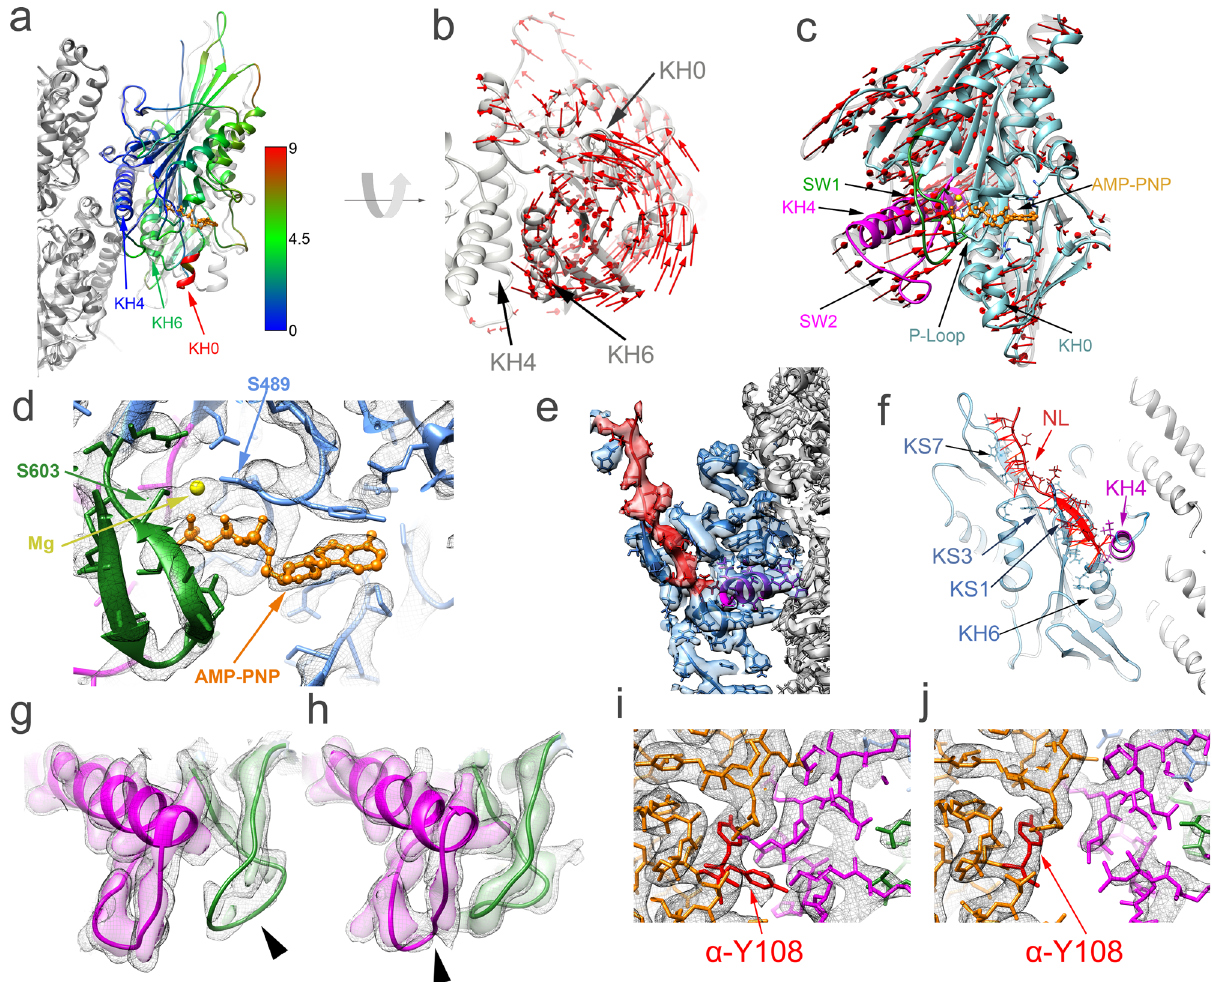
Fig. 4 Closed nucleotide-binding pocket conformation. a Superimposed MT-K748-ANP (colored) and MT-K748-ADP (semi-transparent gray) structures aligned to their corresponding tubulin β -chains. The KIF14 motor domain of the MT-K748-ANP structure is colored by the distance to equivalent C α atoms in the MT-748-ADP structure according to the inset scale (in Å). b Displacement vectors (red arrows) between equivalent KIF14 motor domain C α atoms in the MT-K748-ANP (light gray) and MT-K748-ADP structures after alignment as in ( a ). c Nucleotide-binding pocket comparison with displacement vectors (red) between MT-K748-ADP (semitransparent gray) and MT-K748-ANP (colored) structures after aligning their P-loops. d Detail of the nucleotide-binding pocket with corresponding densities (gray mesh) in the MT-K748-ANP structure. e Detail of the neck-linker domain with corresponding densities (semitransparent colored surface) in the MT-K748-ANP structure. f Neck-linker area in the MT-K748-ANP structure showing interacting residues with other areas of the motor domain. Pseudo-bonds between interacting atoms are represented as red lines (determined and displayed using the fi nd clashes and contacts routine in UCSF-Chimera, see “ Methods ” ). g , h Switch loop regions in the MT-K748-ADP ( g ) and MT-K748-ANP ( h ) structures. Corresponding densities are shown at two iso-density contour levels, higher (colored semitransparent surface) and lower (gray mesh). Densities that disappear at the higher contour level (presumably more disordered) are pointed with the black arrowheads. i , j Detail of the microtubule-KIF14 interface of the MT-K748-ADP ( i ) and MT-K748-ANP ( j ). Cryo-EM density shown as gray mesh iso-density surface. α -tubulin in orange except α -Y108, which is colored red. Note the distinct separation between α -tubulin and KIF14 residues and the alternate rotamer positions of the α -Y108 side chain in the open ADP and closed AMP-PNP structures. The KH4 and SW2 regions are colored magenta, the SW1 in green, the AMP-PNP in orange, the rest of the KIF14 motor in ( c – j ) in blue when present. Tubulin is colored solid gray in ( a ), ( e ), and ( f ). KS1, KS3, KS7 kinesin β -strand 1, 3 and 7; NL neck-linker. Other abbreviations as in Fig. 3